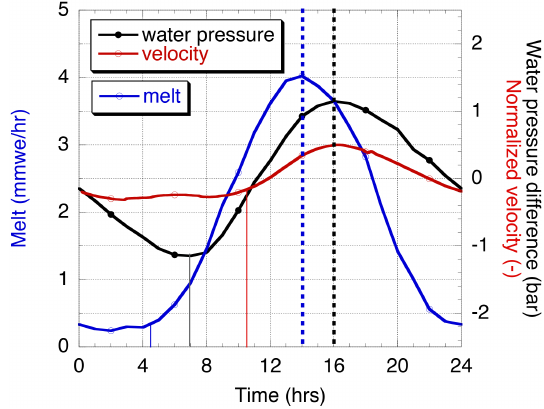
Figure 6. The average daily cycle for a period of 3 weeks in July 2010. Melt production peaks in the afternoon and ceases overnight. Vertical dashed lines indicate peak values and vertical solid lines indicate timing of acceleration in the